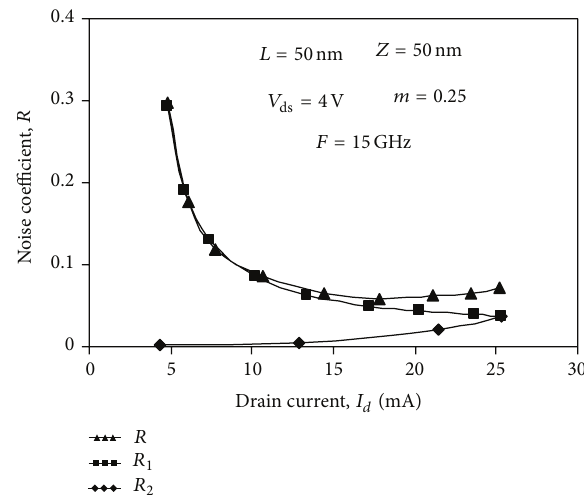
Figure 12: Variation of gate noise coefficient 𝑅 with drain current.